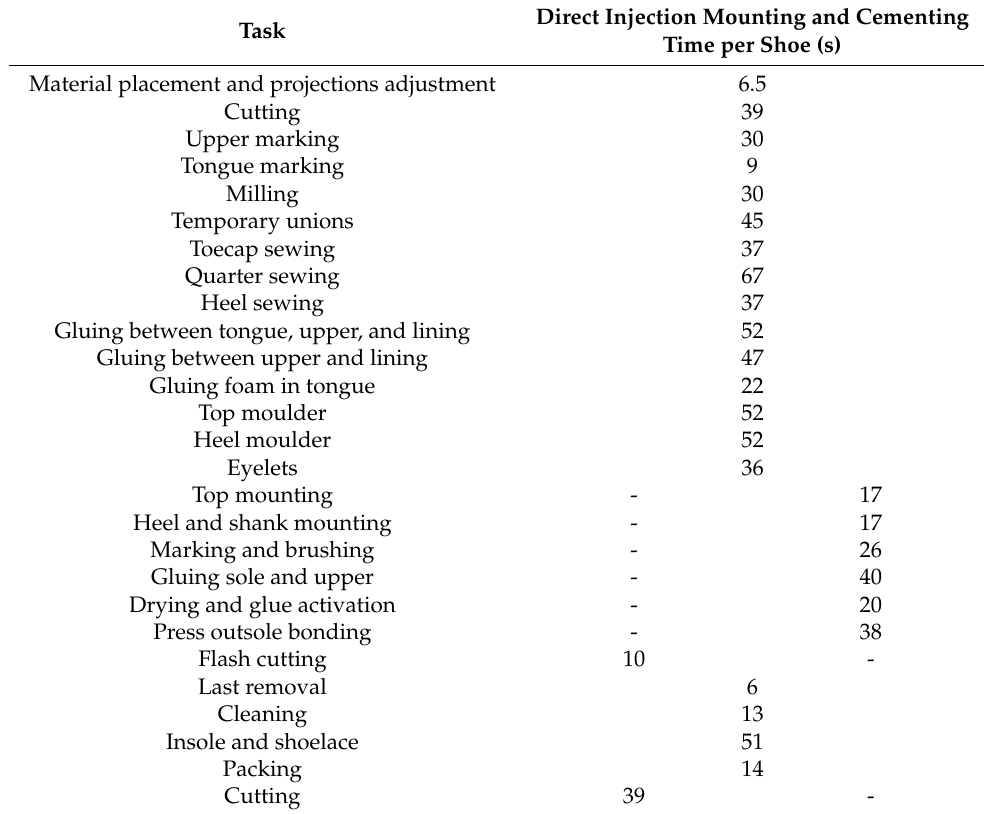
Table 1. Features of optimal sequence for Manufacturer 1 and manufacturing times per product. This information is associated with direct-injection and the mounting-and-cementing process. Direct Injection Mounting and Cementing Task Time per Shoe